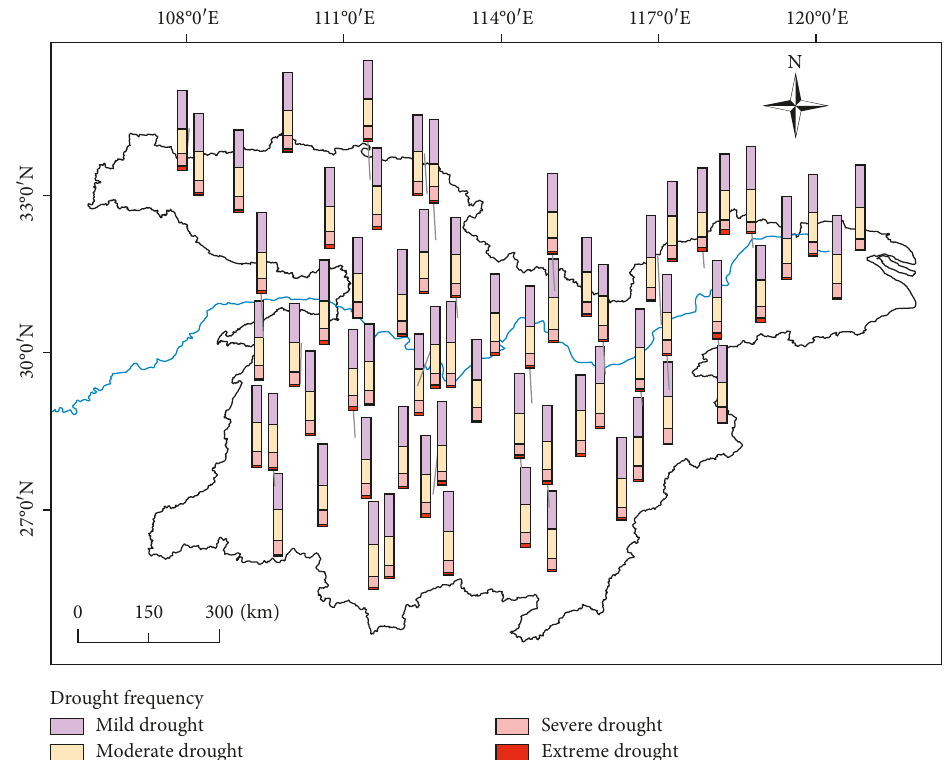
Figure 4: Drought frequency at the 64 meteorological stations in the MLRYRB, as determined using the SPEI-3 values.